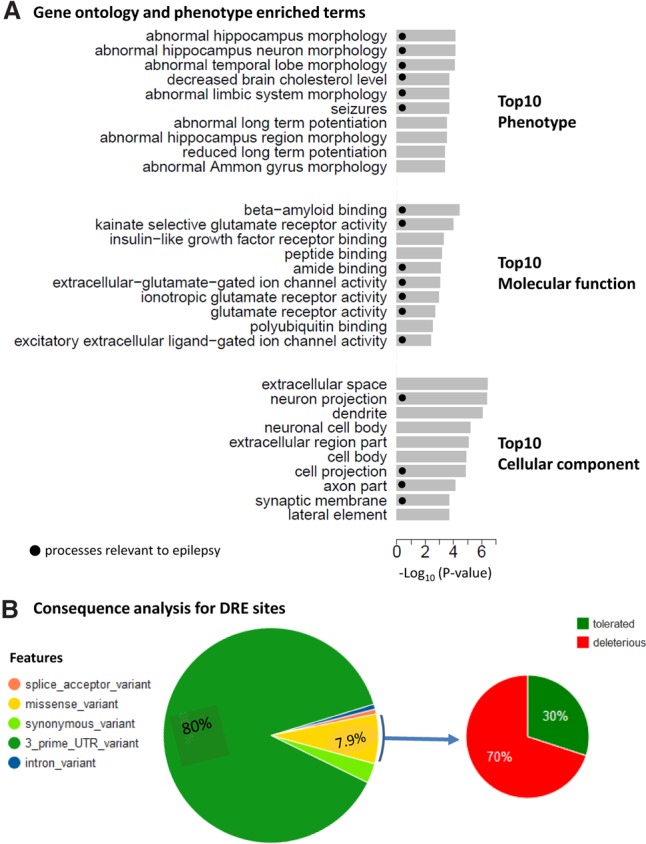
(A) Functional annotation of genes harboring differential RNA-edited clustered sites for Gene Ontology (GO) categories phenotype, molecular function, and cellular component. (B) Consequence analysis of the differential RNA-edited clustered sites.